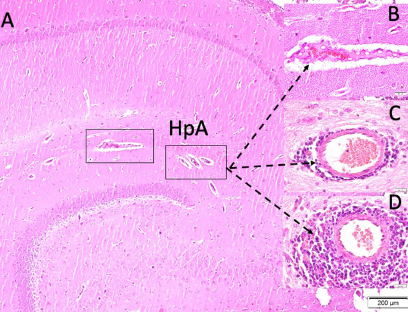
Figure 3. In the control group, the hippocampus is observed together with its neuronal layers and arteries, and a normal artery in the perivascular space is filled with clear cerebrospinal fluid. A slightly narrowed artery surrounded by a few defense cells is seen in the sham group, and a significantly narrowed artery surrounded by many defense cells is seen in the study group.